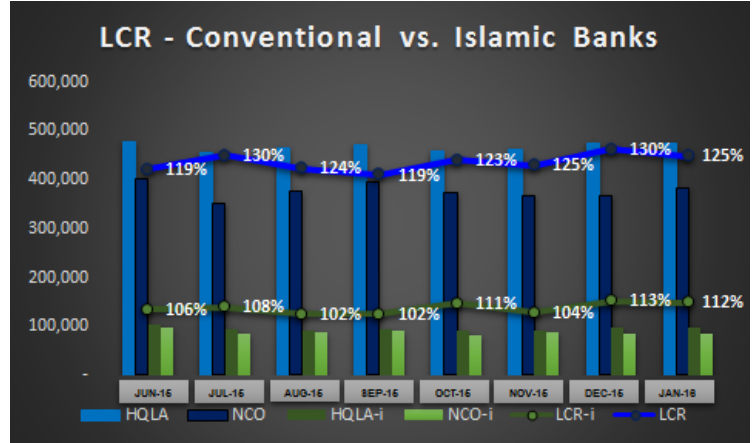
Figure 6. Liquidity coverage ratio (LCR) of conventional and Islamic banks. Source: Bank Negara Malaysia (BNM) Monthly Statistical Bulletin. HQL—high-quality liquid asset. NCO—net cumulative outflow .